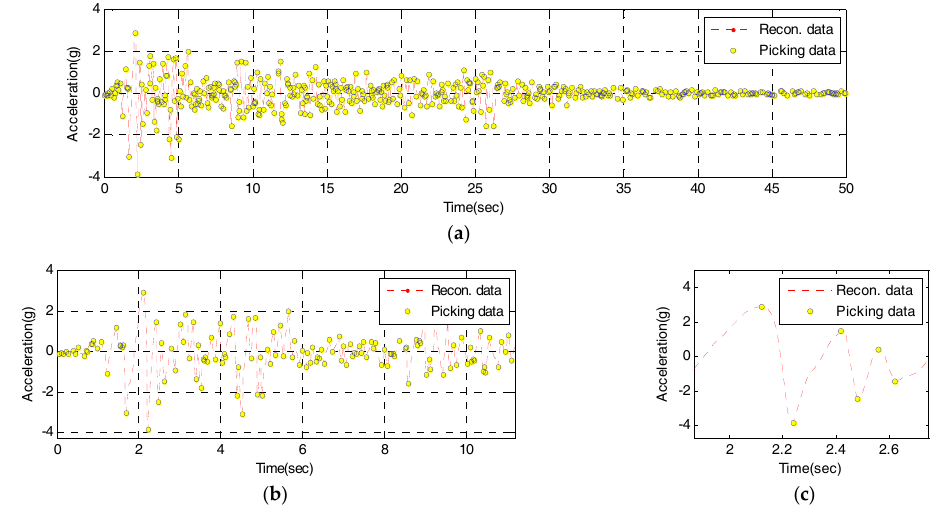
Figure 16. Peak-picking results of the reconstructed signal from the IDAQ system: ( a ) Time from 0 to 50 s; ( b ) Detail 1; ( c ) Detail 2.